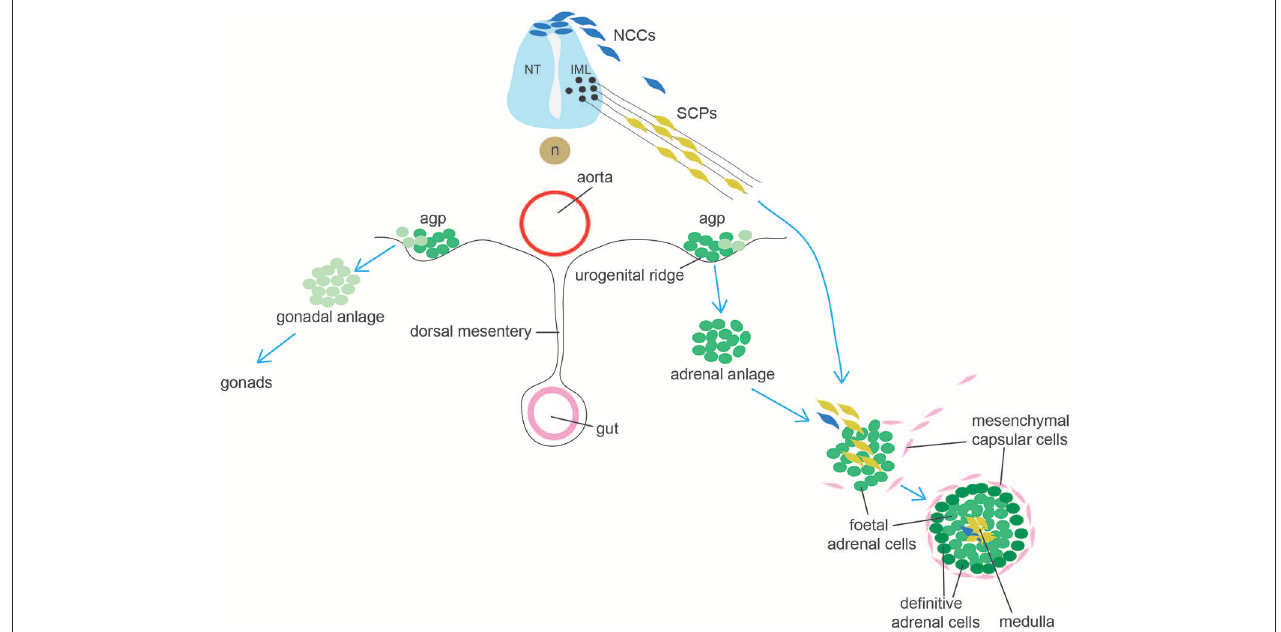
FIGURE 3 | Schematic representation of adrenal gland development. Cells from the adrenogonadal primordium (agp) form the adrenal and gonadal anlage. The adrenal anlage is invaded by migrating medullary progenitors who derive from early migrating neural crest-derived cells (NCCs, a minority in mice) and from late migrating Schwann cell precursors (SCPs). Concomitantly, the adrenal is encapsulated by mesenchymal cells. During late embryogenesis, definitive adrenal cells appears and will substitute fetal adrenal cells. IML: intermediolateral column (IML); NT, neural tube; n,